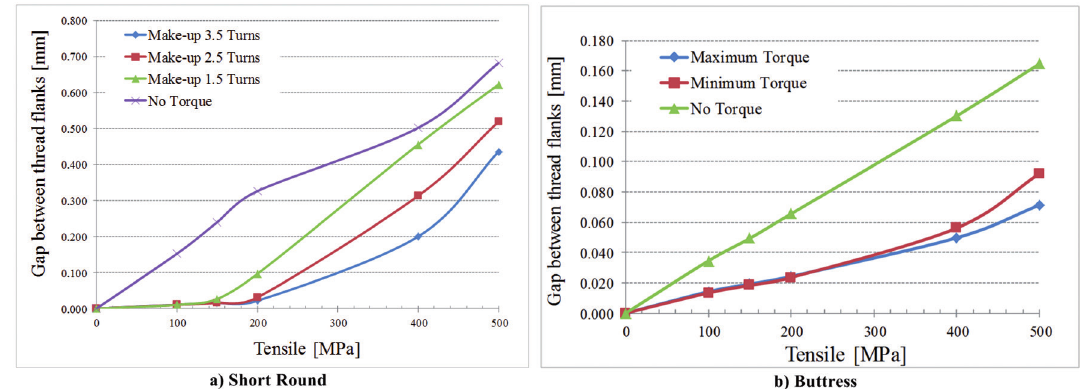
Figure 6: Results of Jump-out tendency of API standard threaded connections as function of make-up torque and tensile stress.